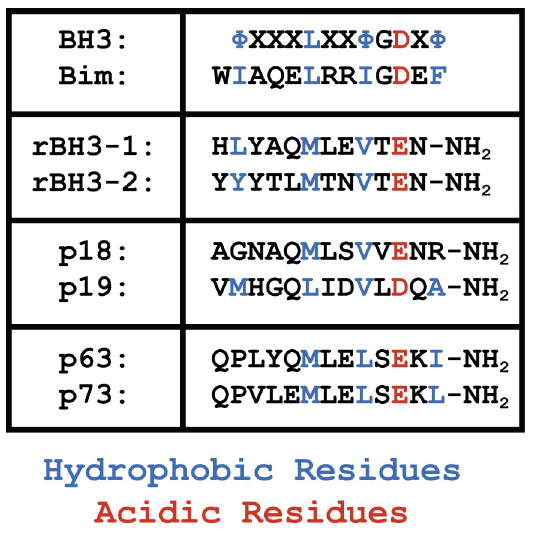
Fig 1. rBH3 motif retains key BH3 motif residues. Alignment of rBH3 and BH3 sequence demonstrate that when the rBH3 sequence is reversed, several conserved hydrophobic and acidic residues of the BH3 motif are maintained [27]. The residues indicated in blue are conserved hydrophobic residues, while the residues indicated in red are conserved acidic residues. The interactions between MCL1 and the rBH3 motif in p18 and p73 were demonstrated in references [28, 29]